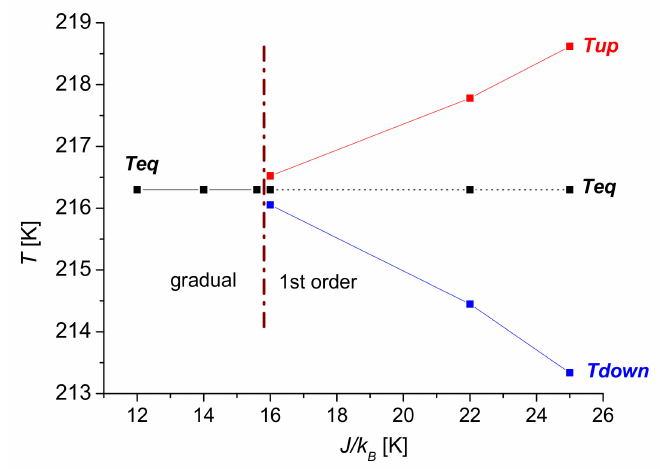
Figure 2. Phase diagram T = f ( J/k B ) for a 6 × 6 square lattice. The red and blue squares correspond, respectively, to the upper and lower transitions for the heating ( T up ) and cooling ( T down ) temperatures of the thermal HS fraction. The black squares correspond to the equilibrium temperatures ( T eq ). The computational parameters are: ∆ / k B = 1300 K, G / k B = 172.2 K, x = J HH / J LL = 1.0 and ln( g ) = 6.01. o The Case of x = J HH / J LL = 0.4